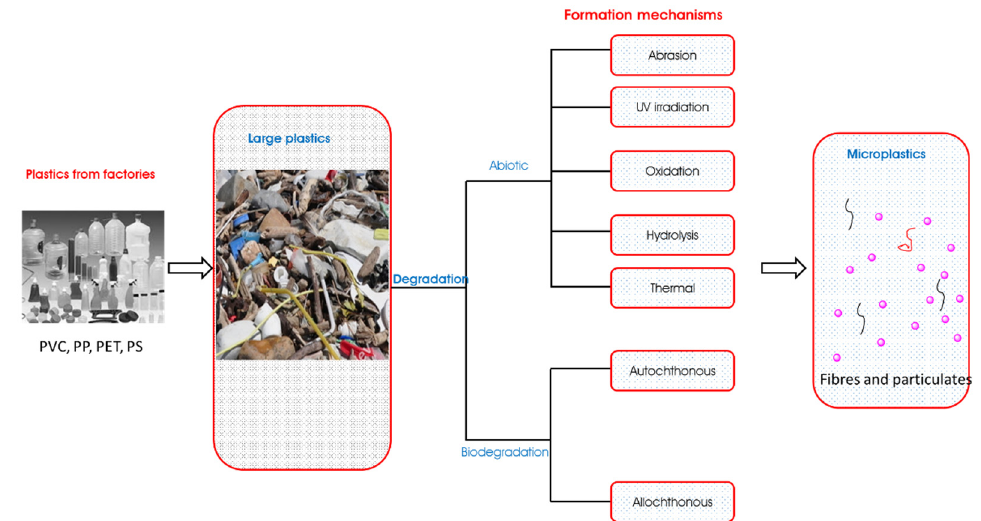
Figure 2. Mechanisms of degradation of plastics into microplastics.